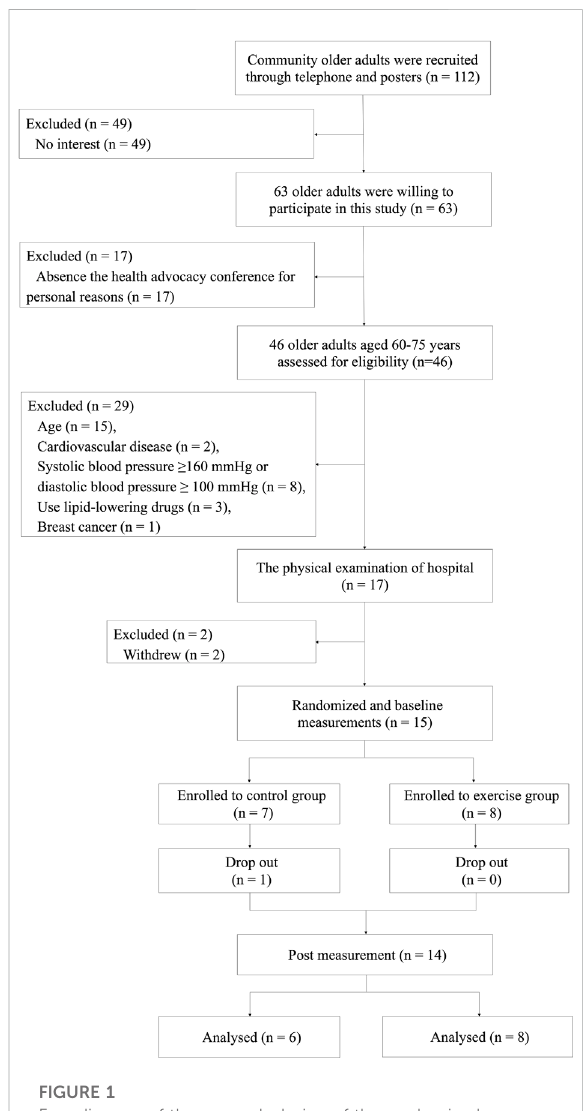
FIGURE 1 Fow diagram of the research design of the randomized controlled trial. Recruitment, screening, randomization, intervention, outcomes assessment, and data